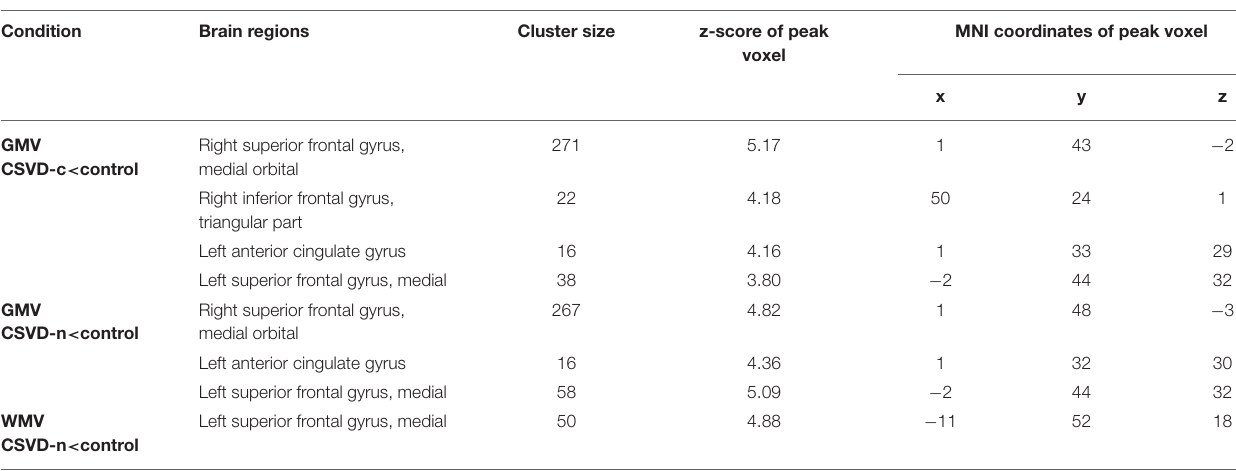
TABLE 2 | Significant altered GMV and WMV among three